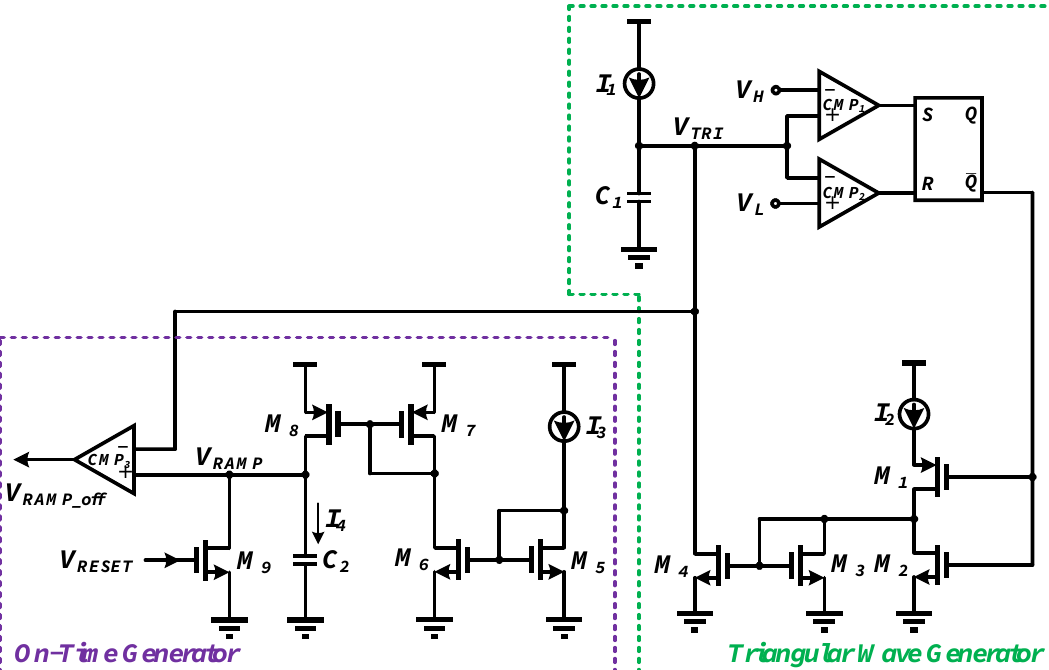
Figure 6. Schematic of the proposed triangular spread-spectrum generator.